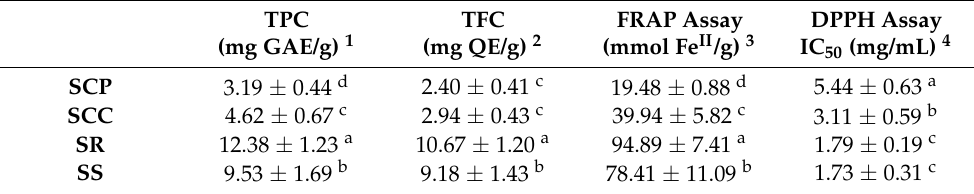
Table 2. Total phenolics (TPC), total flavonoids (TFC), and antioxidant properties (DPPH radical scavenging activity and ferric ion reducing power (FRAP)) of the Sideritis aqueous extracts. The results are expressed as average values ± standard deviation (SD) of triplicate analysis (n = 2 biological samples per taxon). Significant differences among group means were determined by ANOVA and post-hock Tukey’s test (a = 0.05) and are indicated with different letters in superscript. The same letter indicates no statistically significant differences across rows at the confidence level of